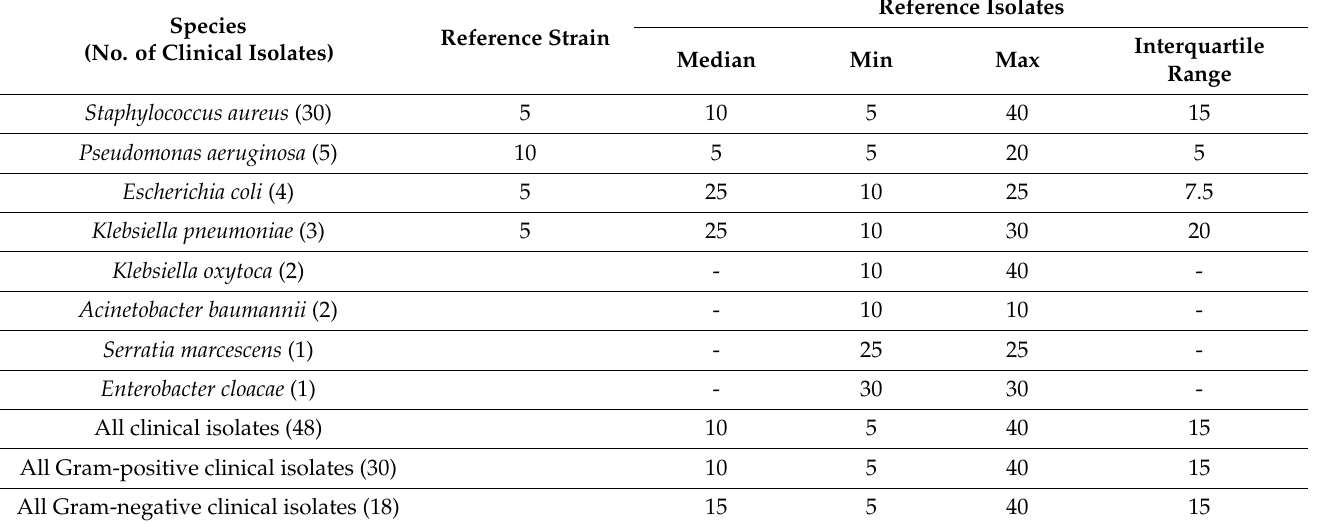
Table 1. The upper limit of minimal inhibitory concentration (MIC) of TA-AgNPs for the reference strains and clinical isolates (mg L − 1 ). MIC values did not have a normal distribution; therefore, the median was used as a measure of central tendency and the interquartile range was used as a measure of statistical dispersion. Higher MIC values indicate a lower sensitivity to TA-AgNPs.